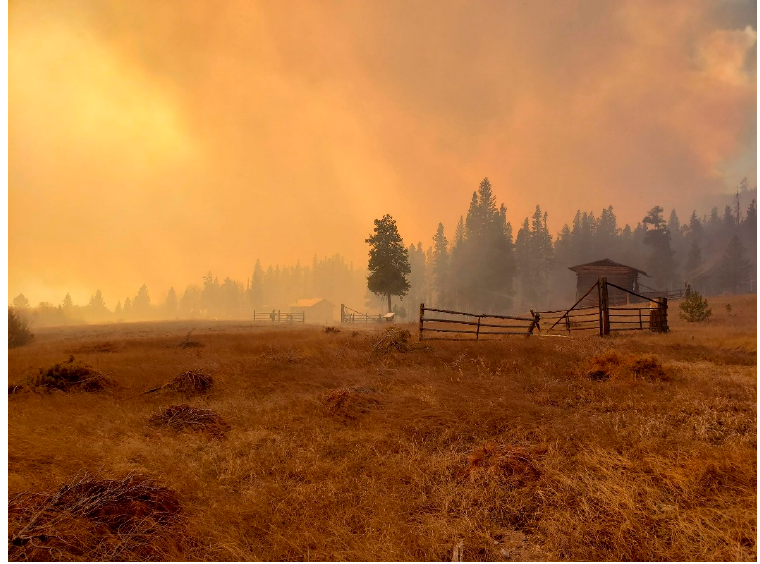
Figure 1. Smoke and ash from the Cameron Peaks fire filled the valley and surrounded the historic Koenig-Ramsey Homestead District at Colorado State University. The heroic efforts of several fire crews successfully protected the >100 years old structures.